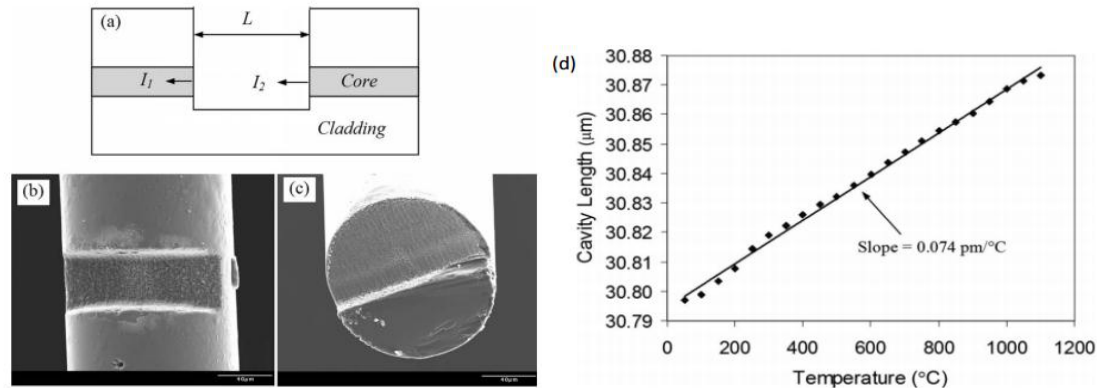
Figure 7. Schematic structure and SEM images of fiber inline FPI device fabricated by femtosecond laser ablation and corresponding response to temperature variation. ( a ) Structural illustration; ( b ) Top view; ( c ) Cross-section; ( d ) Temp. vs. Cavity